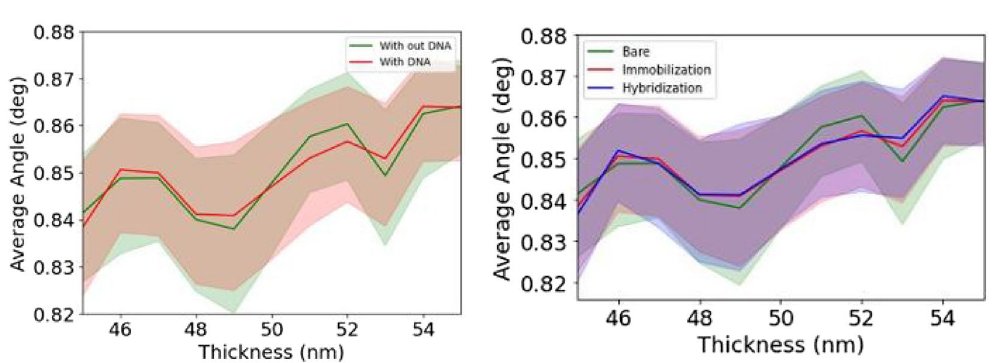
Figure 5. Gold thickness variances at different average angles for DNA detection (left) and classification (right) tasks.